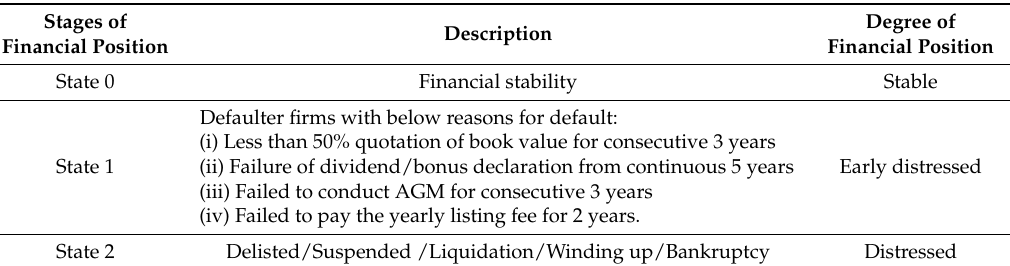
Table 9. Stages of financial distress.